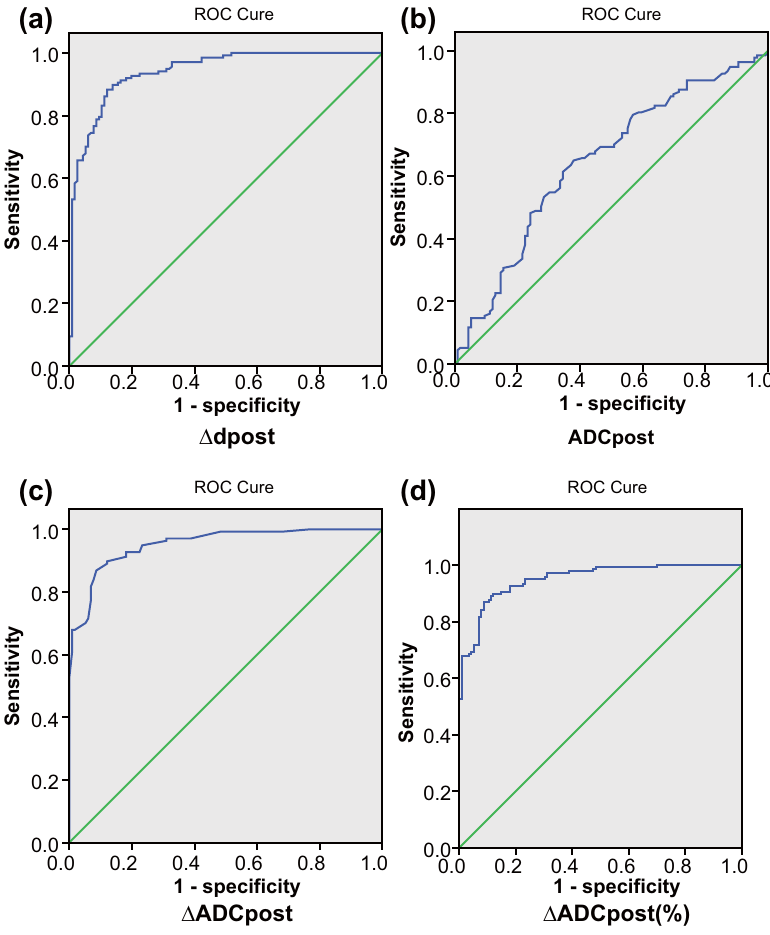
Figure 2: ROC curve analysis of ADC value. Note: ( a ) Δ d post , ( b ) ADC post , ( c ) Δ ADC post , and ( d ) Δ ADC post ( % ) .